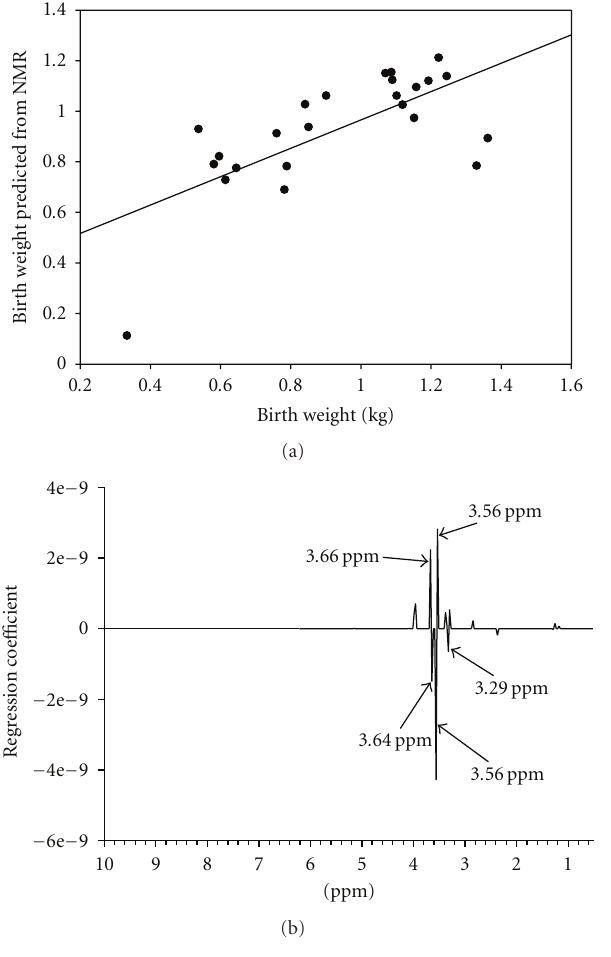
Figure 2: Prediction of birth weight by the 1 H NMR metabolite profile of plasma samples from low birth weight (LW) and high birth weight (HW) piglets. (a) Predicted versus measured birth weight from PLS regression with NMR-variables as x -variables and measured birth weight as y -variable. Values are given in Kg. R 2 = 0 . 47, Root mean squared error of prediction = 0 . 21 Kg. (b) The corresponding regression coe ffi cients. The regression coe ffi cients show the relationship between the NMR variables used as predictors for the birth weight. A positive coe ffi cient shows a positive link with birth weight, and a negative coe ffi cient shows a negative link. NMR variables with a small coe ffi cient are negligible.